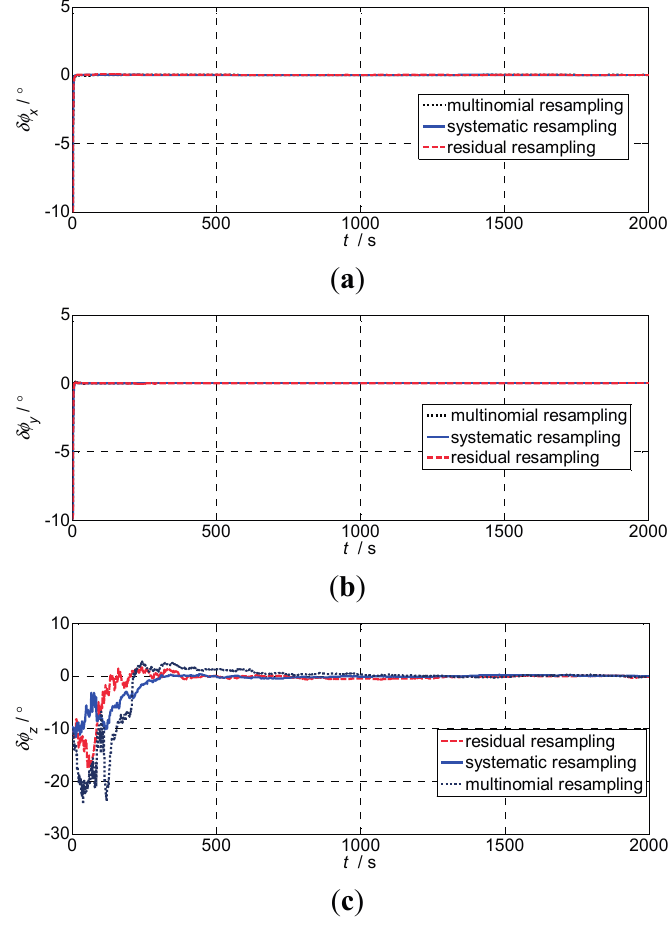
Figure 3. The influence of different re-sampling algorithms on alignment accuracy: ( a ) Pitch errors; ( b ) Roll errors; ( c ) Heading